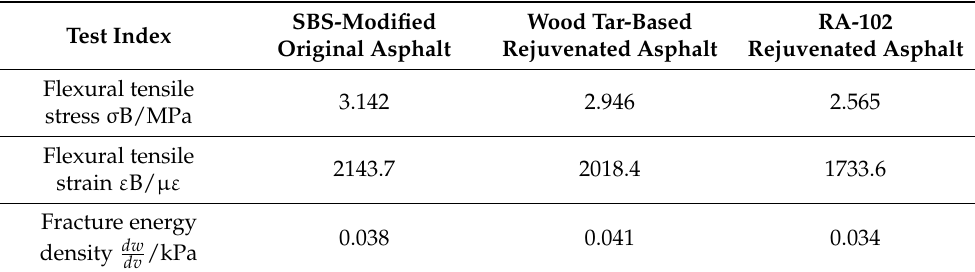
Table 7. SCB test results of each asphalt